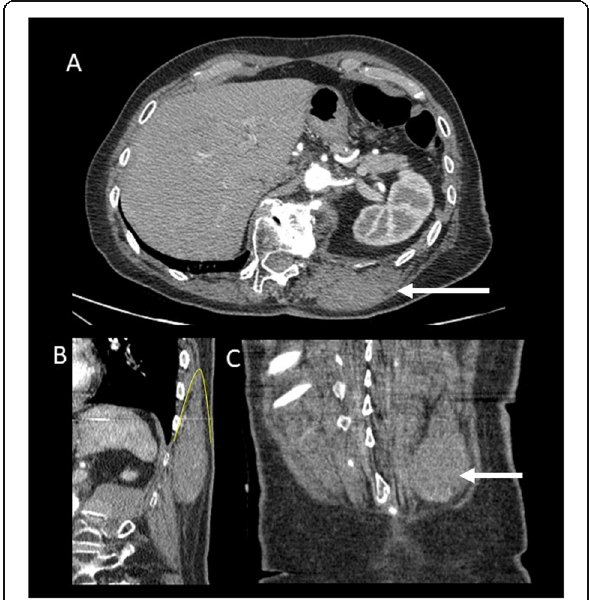
Fig. 1 Patient with a previous history of non-Hodgkin lymphoma. CT imaging shows a homogenous mass located superficially to the left paravertebral muscle (arrow). In the oblique ( b ) and coronal ( c ), the fascial tail sign is shown (yellow line in b ) indicating thin linear extension along the fascial plane. Histologic analysis confirms the diagnosis of paravertebral